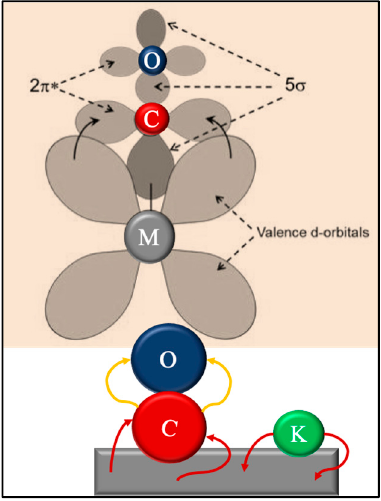
Figure 34. An atomic view of how the alkali could be affecting CO bonding.